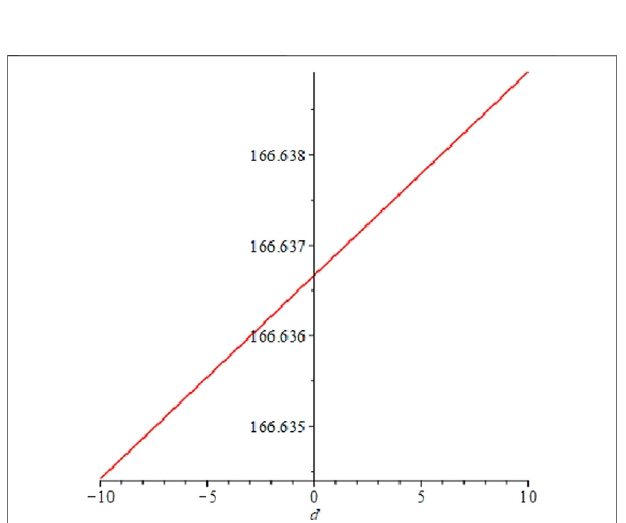
FIGURE 6 | (A) The relationship between electricity Q 3 saving in enterprise E 3 with h and d (cid:6) 0 < λ < 0 . 5 (cid:7) . (B) The relationship between electricity Q 3 saving in enterprise E 3 with h and d (cid:6) 0 . 5 < λ < 1 (cid:7) .